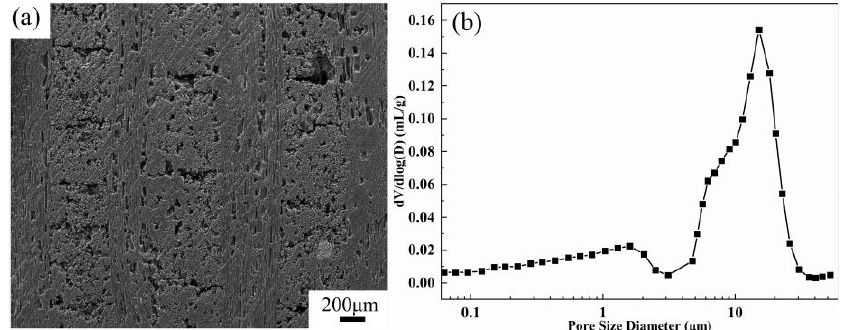
Figure 1. SEM image ( a ) and pore-size distribution ( b ) of the C/C